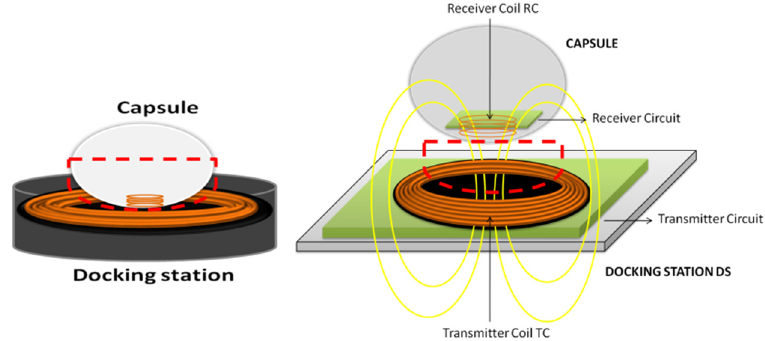
Figure 8. Schematics of the intended operation for the capsule recharging system: docking station ( Left ) and coupling between internal and external coils ( Right ).